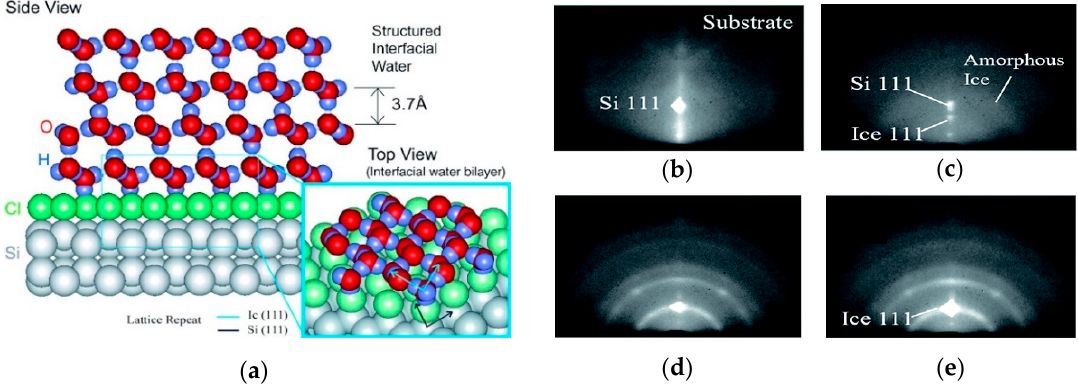
Figure 2. ( a ) Schematic illustrating the structural water adsorbed on the Cl-terminated Si(111) surface. This ordered water film structure lasts up to three to four layers and forms crystalline islands. ( b – e ) showing the evolution of in situ growth of ordered ice water on the Cl-terminated silicon surface at a cold temperature of 110 K. The adsorption of water on the substrate can be seen from the disappearance of 111 silicon Bragg points ( b ) and the formation of 111 crystal ice Bragg points, along with the di ff raction ring of amorphous ice ( c ). The structure is stable when the rings, spots and fringes are almost unchanged as di ff raction shows ( d , e ). Reprinted from Ref. [22,23], Copyright 2004, with permission from Science.